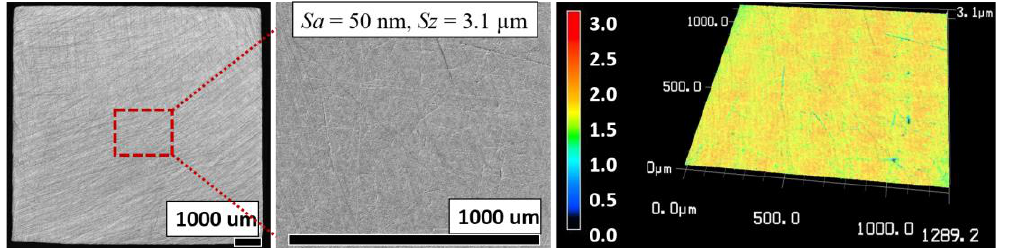
Figure 7. Optical images and 3D images acquired by a laser confocal microscope of a Nb sample after step 1.